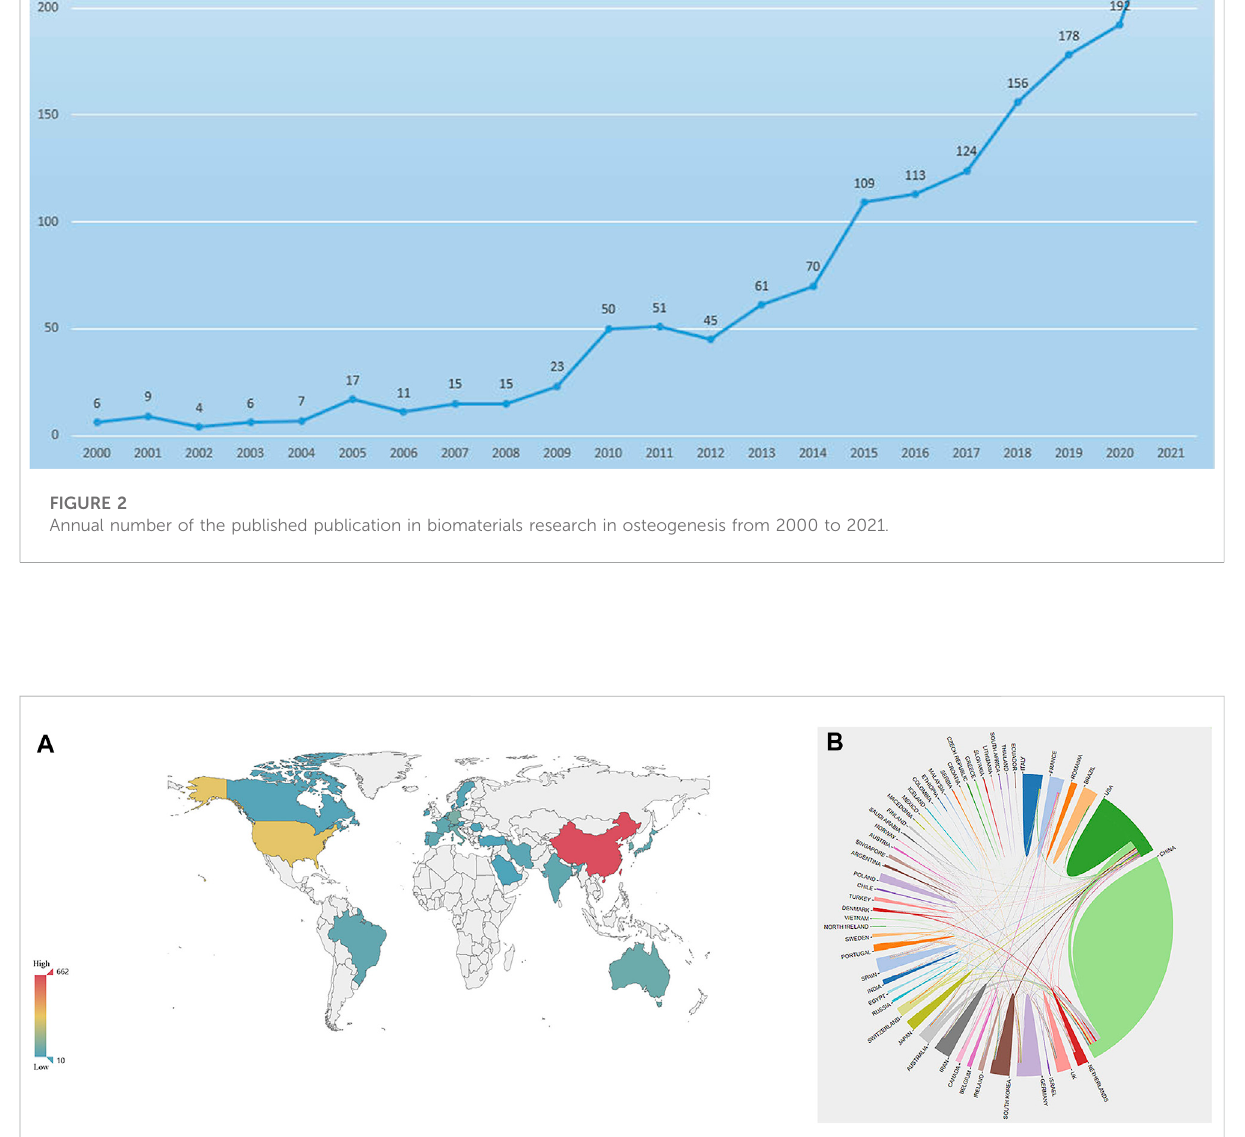
FIGURE 3 The distribution of countries or regions in biomaterials research in osteogenesis. (A) Distribution of biomaterials research in osteogenesis literatures in the world map. The color of each country or region on the world map represents the amount of literature published, according to the color gradient in the lower left corner. (B) The network map of cooperation between countries or regions. Different colors represent different countries or regions, the area of each color represents the amount of literature published in each country or region, and the thickness of the connecting line indicates the cooperation